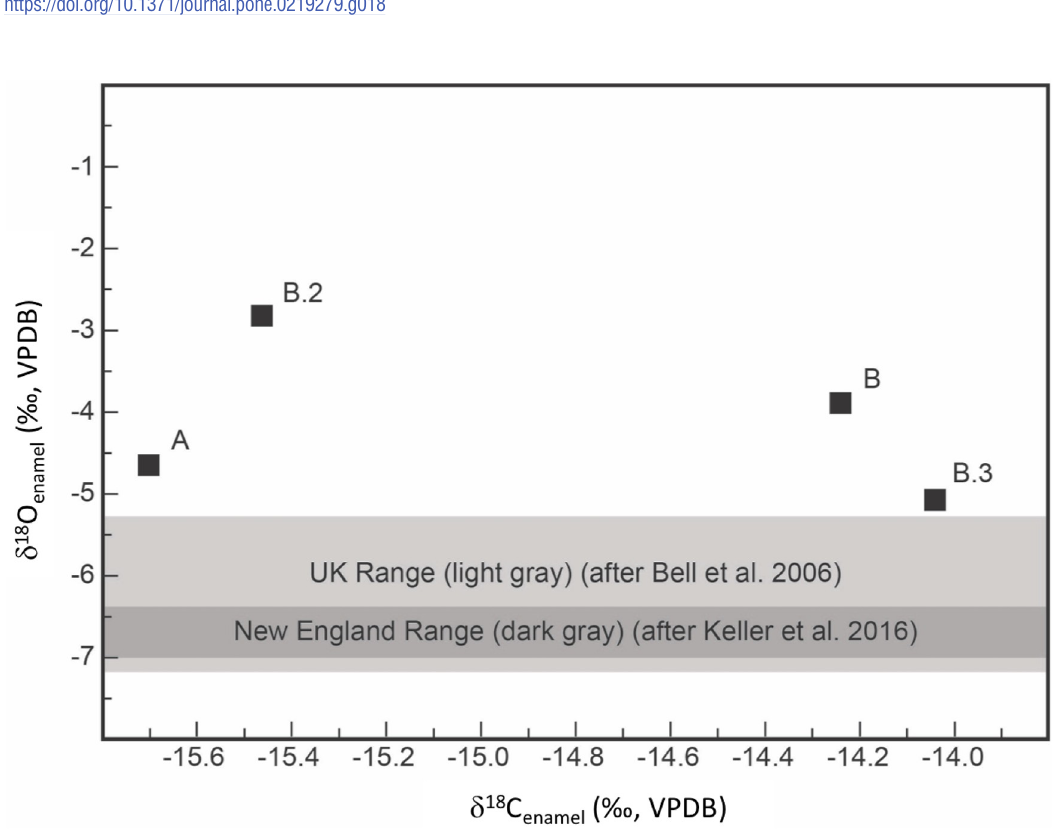
Fig 19. YNH4 tooth oxygen and carbon isotope values, and published geographic